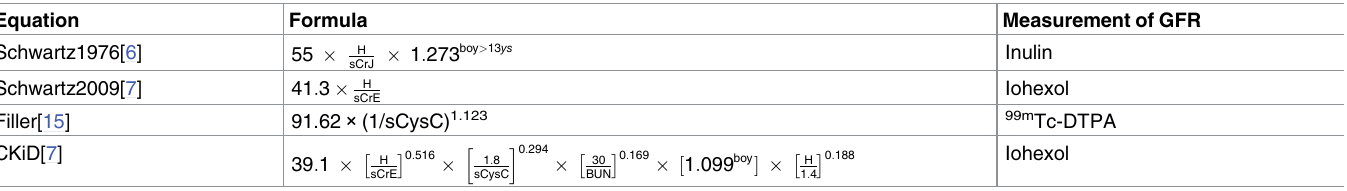
Table 1. Details of the GFR estimating equations.